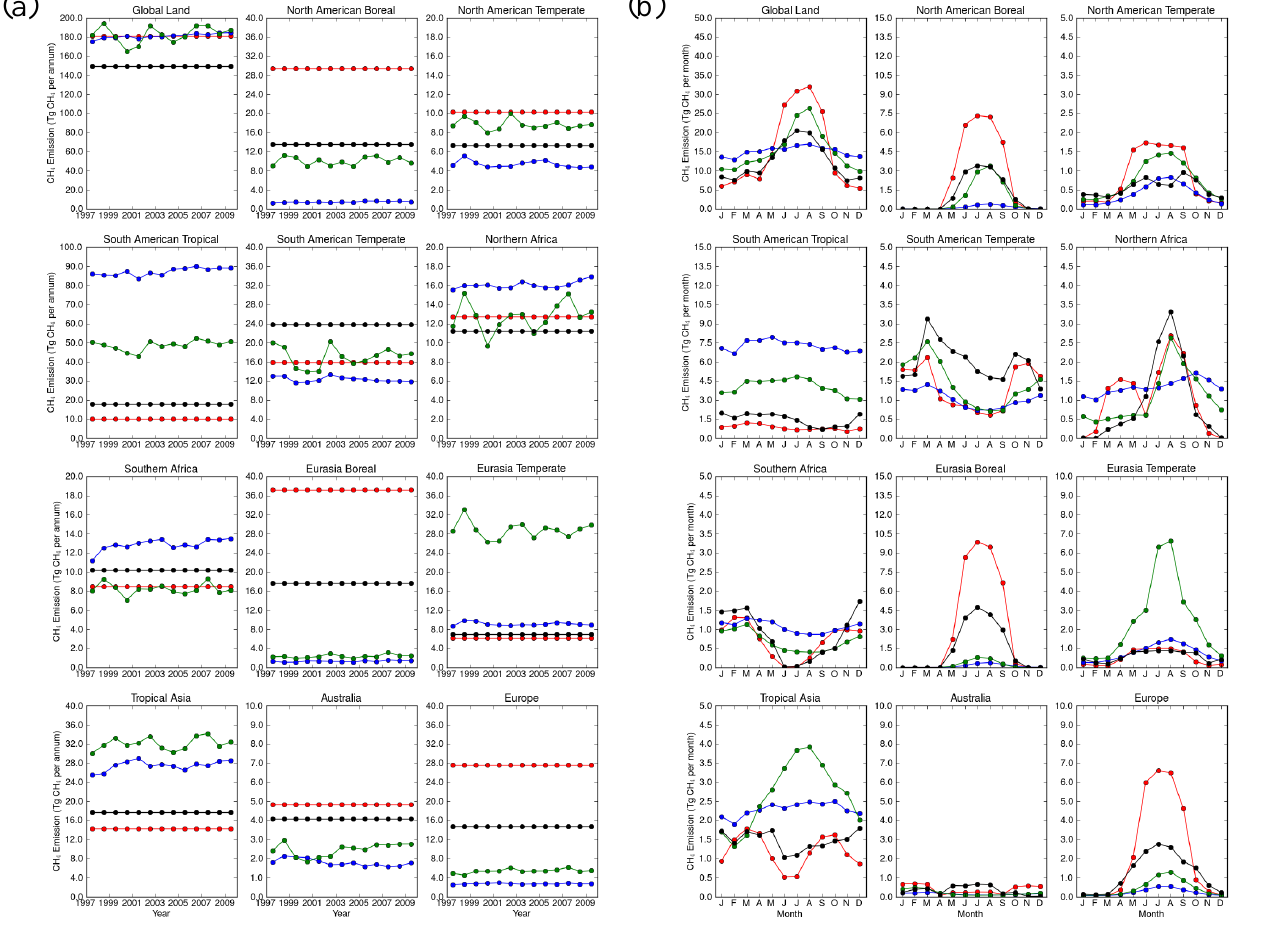
Figure 1. Time series of the area-weighted annual wetland emissions for all land surface points and for the 11 terrestrial TRANSCOM regions (left-hand panel) for the Fung et al. (1991) wetland data sets (red: as used by O’Connor et al. (2014); black: TRANSCOM-FUNG) and for the JULES wetland estimates (blue: JULES; green: JULES-GIEMS). The right-hand panel shows the corresponding mean annual